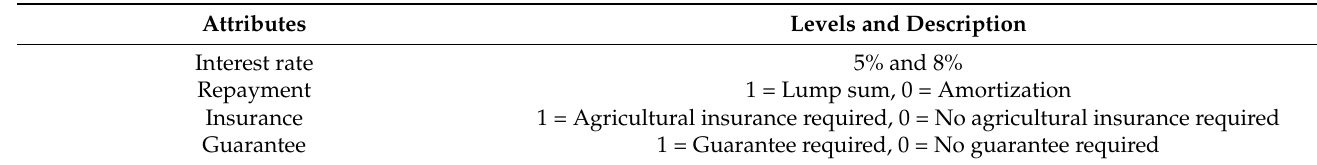
Table 1. Attributes and levels used in the direct choice experiment.